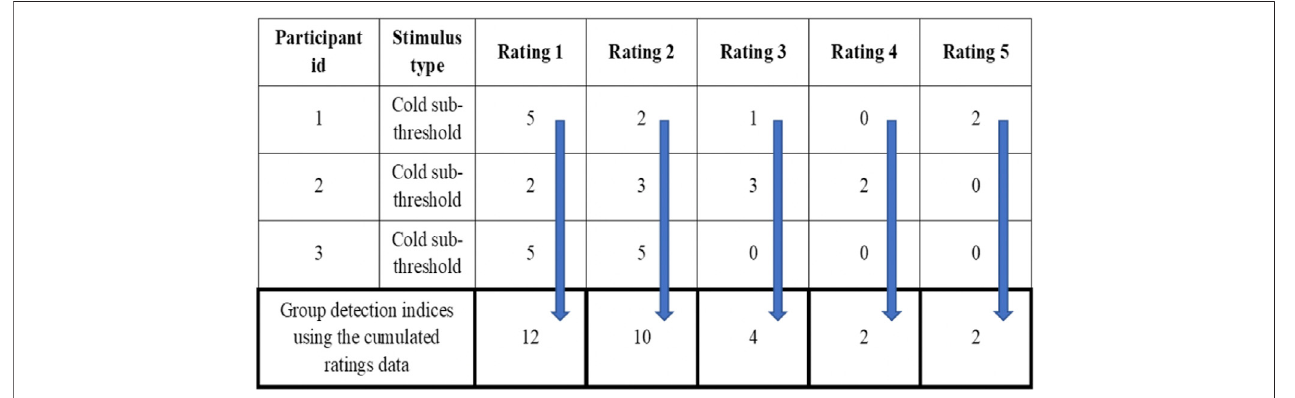
FIGURE 2 | Example for the cumulated ratings to calculate group detection indices and draw group ROC